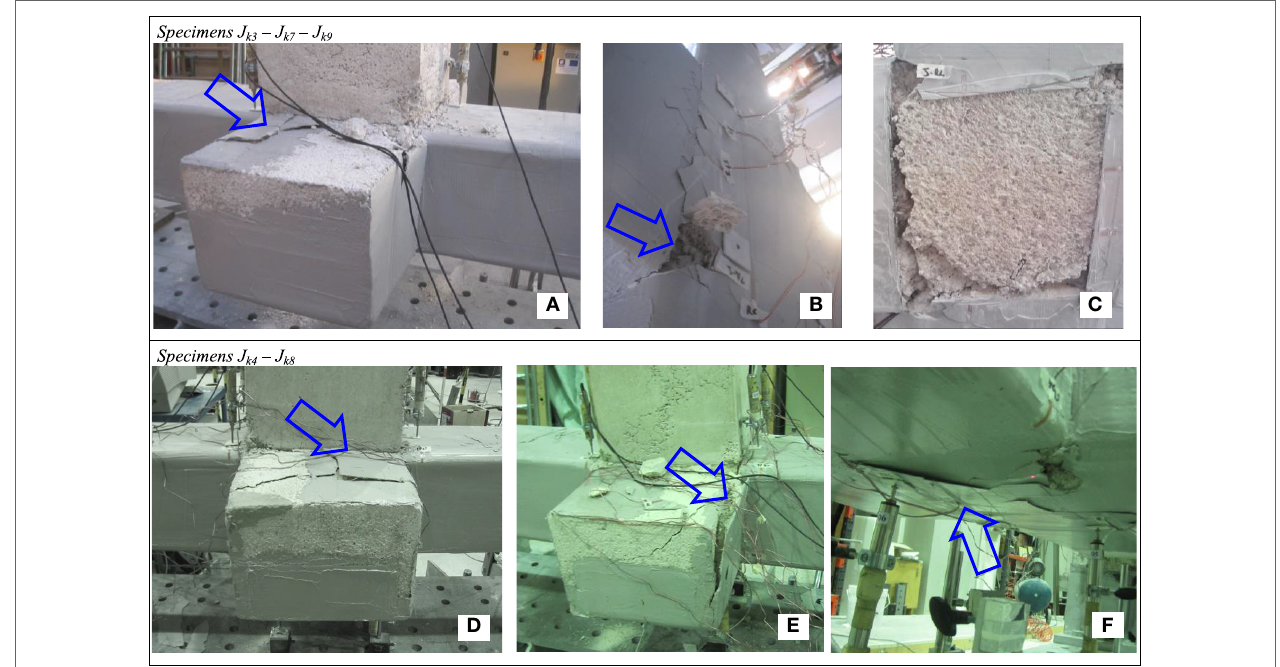
FIGURE 8 | Crack pattern and failure for SRP strengthened specimens: J K3 , J K7 , and J K9 (A–C) ; J K4 and J K8 (D–F) .